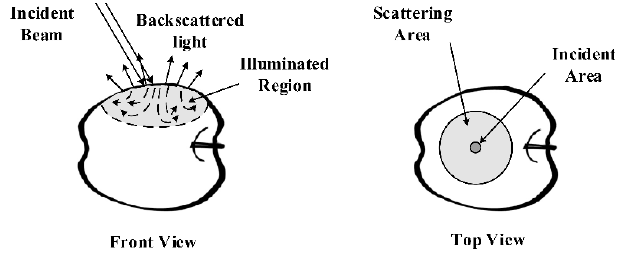
Figure 5. Schematic of light scattering within fruit resulting from a sharp, focused incident beam.